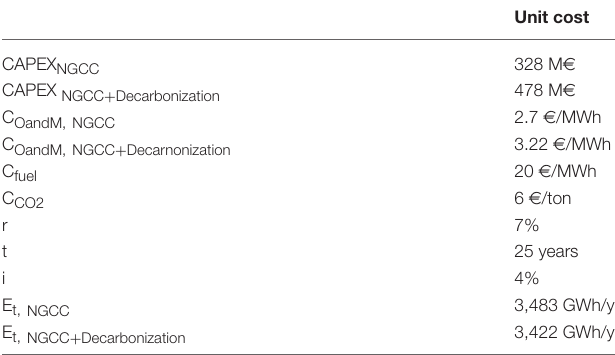
TABLE 1 | Main parameters for the economic analysis of NGGC with direct